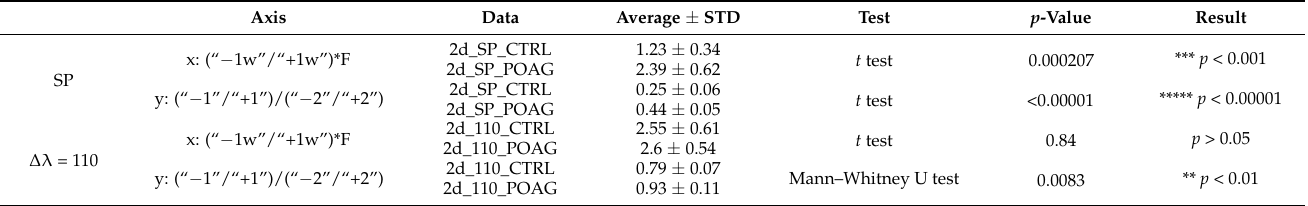
Table 2. Results of statistical analysis of patients POAG and healthy subjects